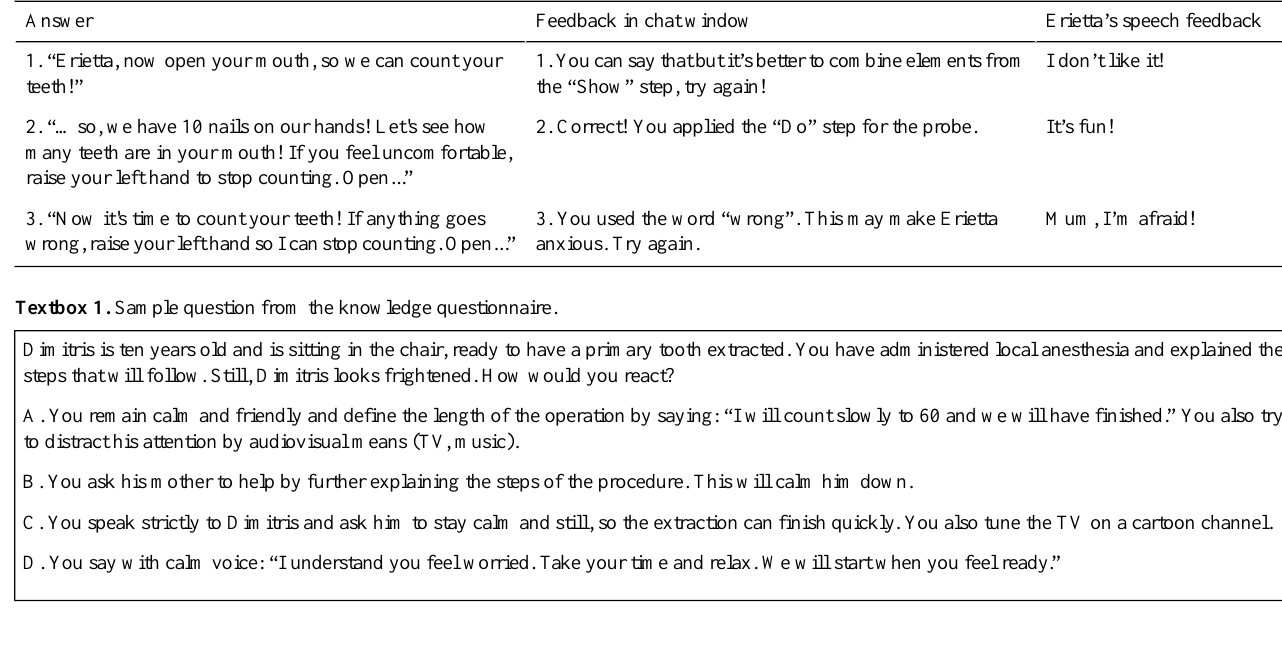
Table 1. Sample question for users to answer: "After the “Tell” and “Show” steps using the probe on Erietta’s nails, what is the best way to ask Erietta open her mouth?"